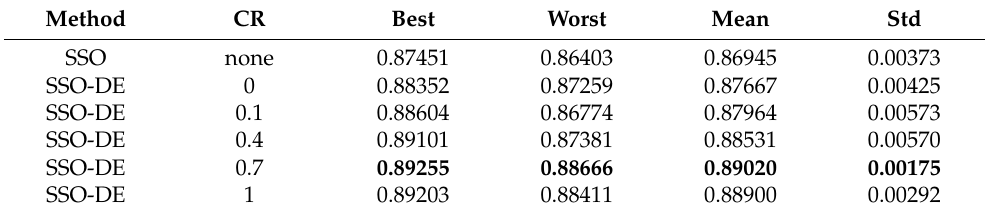
Table 18. Comparison of SSO and SSO-DE for spring (autumn).